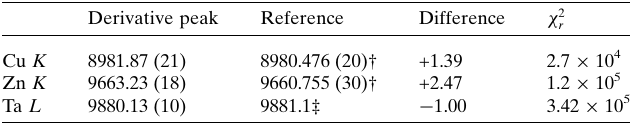
Table 6 Results from fitting the reference foils are inconsistent – reference and deviations do not follow a physical progression with